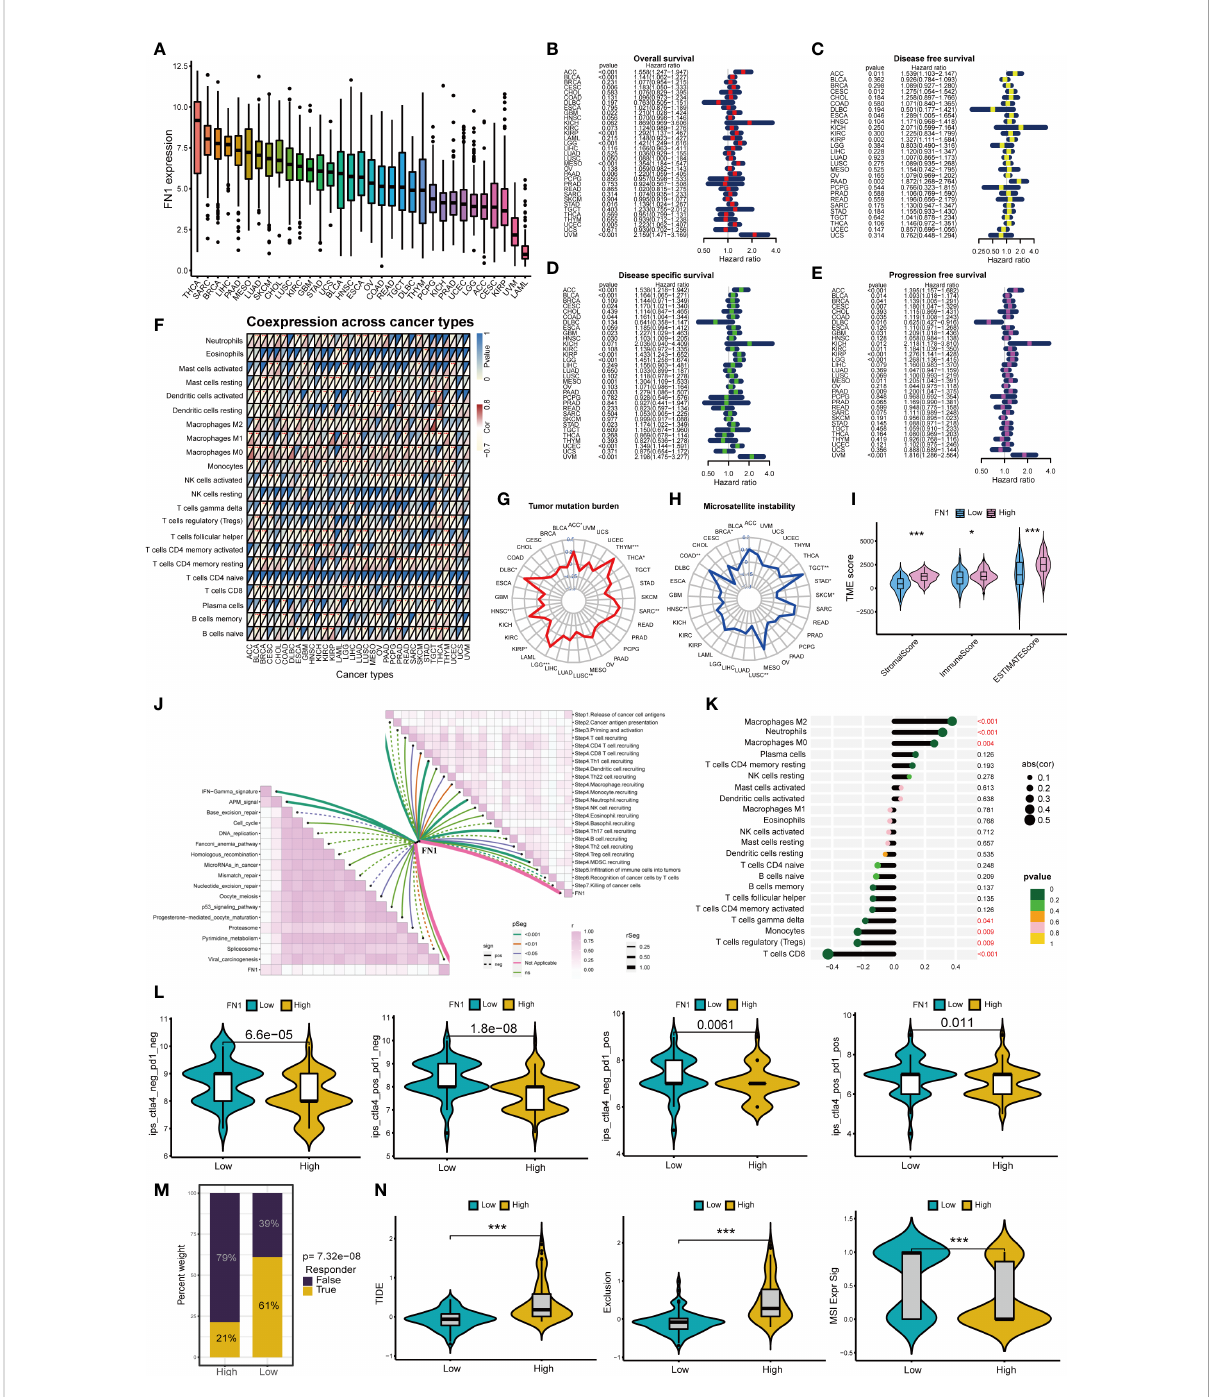
FIGURE 8 Analysis of FN1 in cancers. *p<0.05; **p<0.01; ***p<0.001. (A) Expression of FN1 in 33 cancers. (B) Overall survival of FN1 in pan-cancer. (C) Disease free survival of FN1 in pan-cancer. (D) Disease special survival of FN1 in pan-cancer. (E) Progression free survival of FN1 in pan-cancer. (F) Co-expression analysis of FN1 and immune cells in pan-cancer. (G) Tumor mutation burden of FN1 in pan-cancer. (H) Microsatellite instability of FN1 in pan-cancer. (H) (I) ESTIMATE analysis of FN1 high- and low-expression group. (J) Correlation between FN1, immunotherapy pathway and cancer immunity cycle. (K) Correlation analysis between FN1 and CIBERSORT immune cells. (L) Response rate of ICIs in FN1 high- and low-expression group. (M) Response of immunotherapy treatment in FN1 high- and low-expression group. (N) TIDE analysis of FN1 high- and low-expression